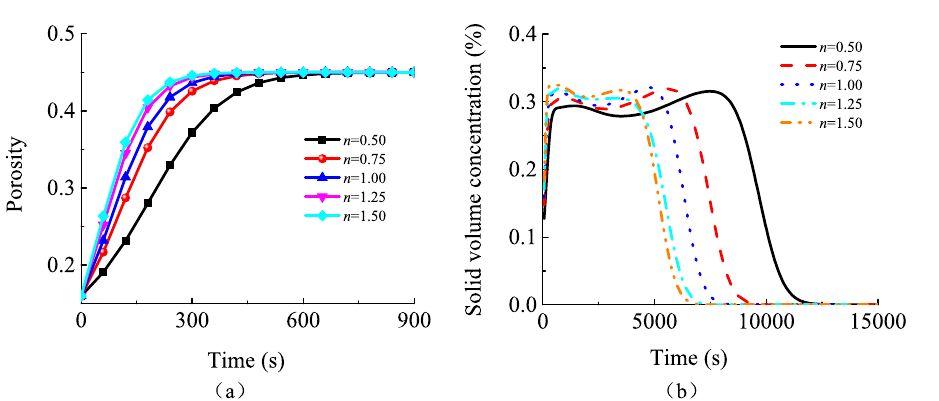
Figure 16. History of porosity and solid volume concentration at monitoring point A 3 under different values of n : ( a ) porosity; ( b ) solid volume